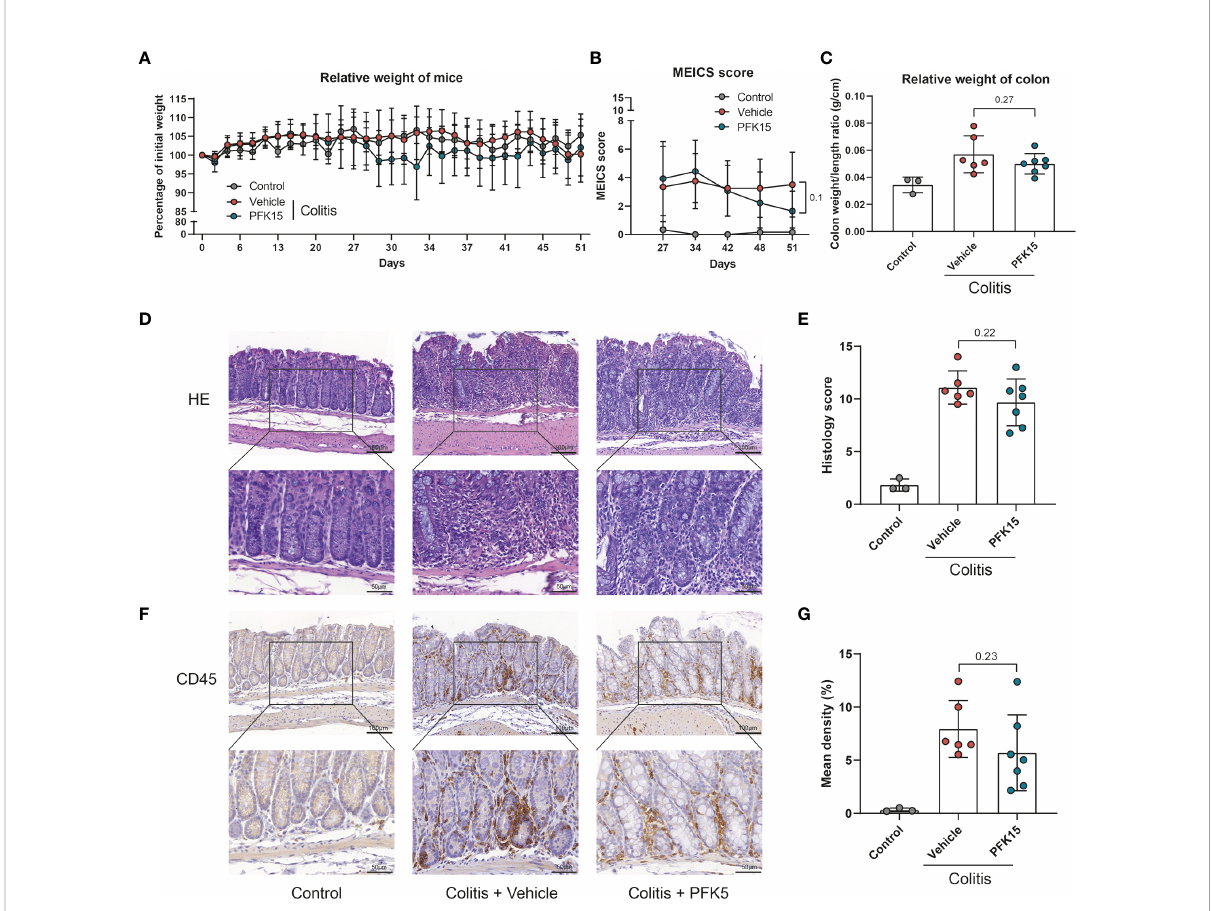
FIGURE 6 Inhibition of PFKFB3 attenuated in fl ammation in T cell transfer colitis. Rag -/- were received 500,000 CD4+CD45RB high T cells or PBS (control group, n=3). Upon development of colitis at around day 27, they were randomized as PFK15 (n=7), or vehicle (n=6) group based on equal average MEICS score. PFK15 (25mg/kg) or DMSO (equal volume) was injected intraperitoneally every three days. (A) Body weight of mice expressed as the percentage of body weight at day 0. (B) MEICS score of the mice in every group at day 27, -34, -42, -48 and -51 (sacri fi ce). (C) Colon weight/length ratio (g/cm) of the mice upon sacri fi ce. (D) Representative hematoxylin and eosin staining of the colon. (E) Quanti fi cation of IBD histology score of the colon. (F) Representative immunohistochemical staining for the immune cell marker CD45. (G) Quanti fi cation of the percentage of CD45 positive stained area. Unpaired two-tailed t-test was performed to assess statistical signi fi cance between vehicle and treated mice. Scale bar, 100 m m (upper panel) or 50 m m (lower